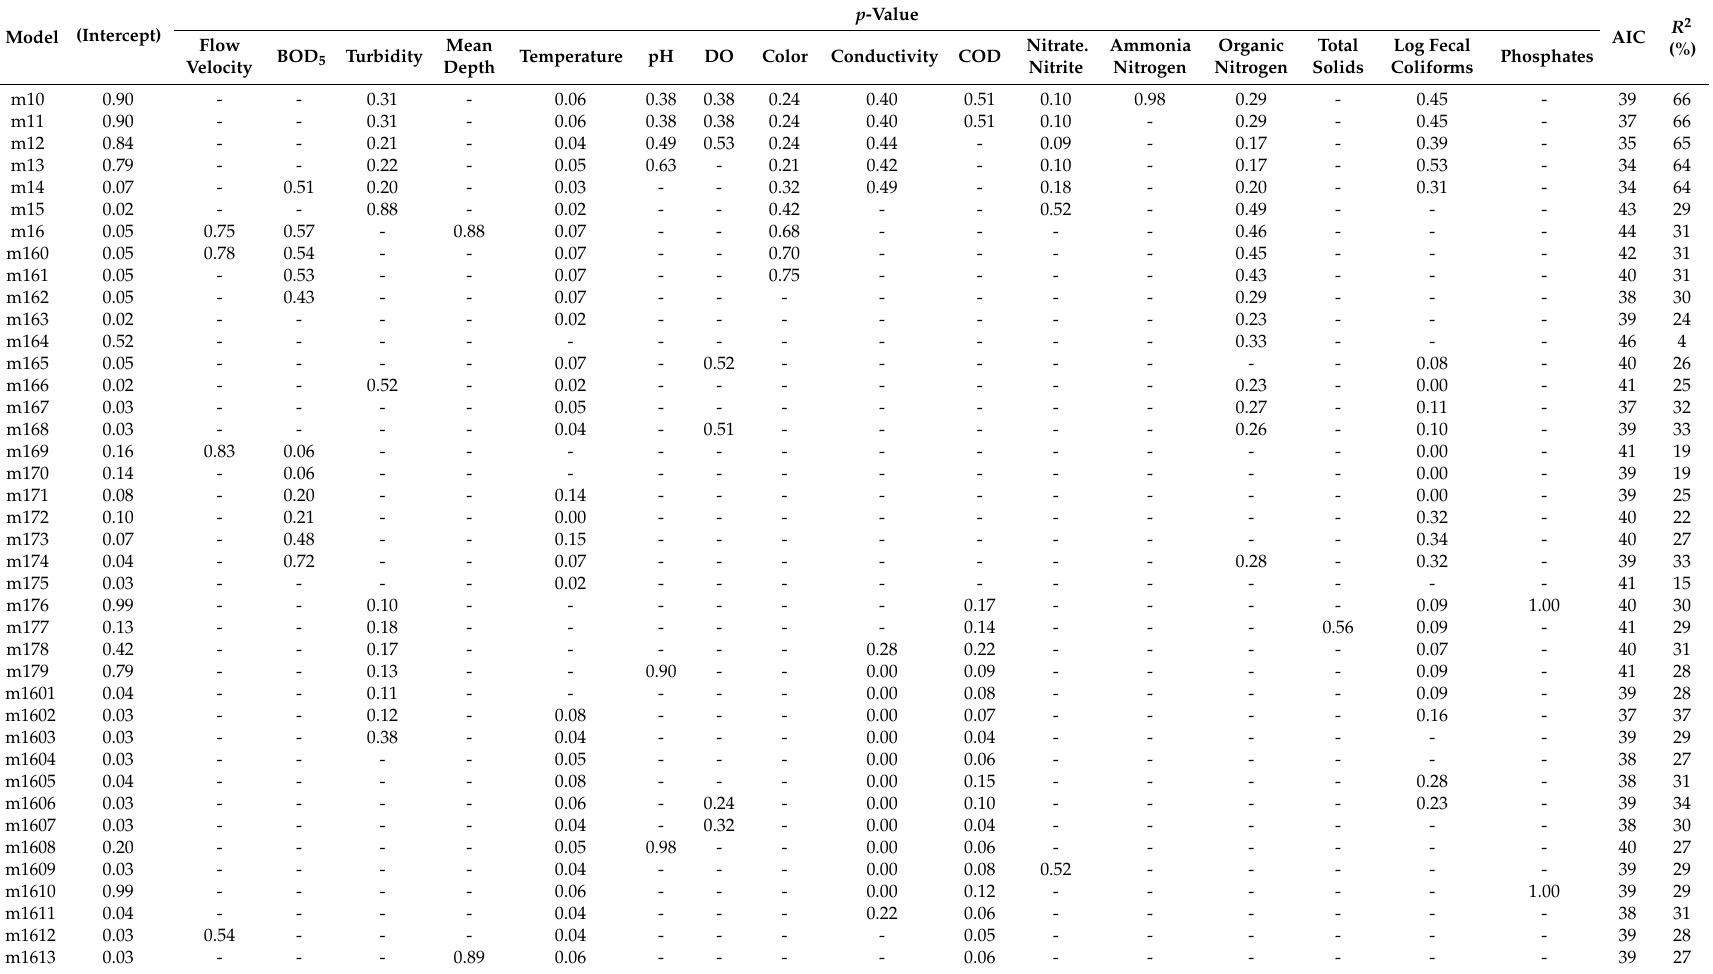
Table A5. Process of model development for Perlidae : p -values, AIC and adjusted R 2